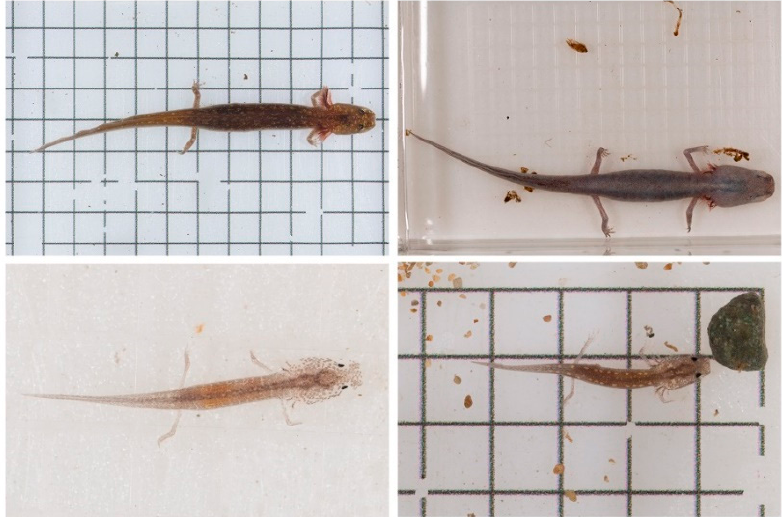
Figure 6. Representative images of salamanders, clockwise from top left: adult Eurycea sosorum , adult E. waterlooensis , juvenile E. waterlooensis specimen previously misidentified as E. sosorum , and E. waterlooensis assigned by expert identification and clustering. Note that eyes are well developed in juveniles of E. waterlooensis .